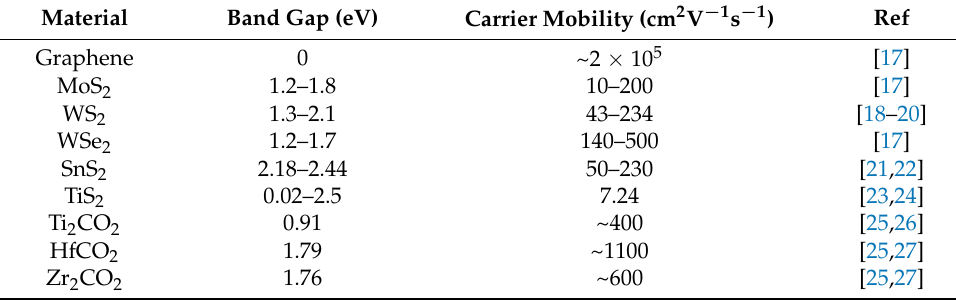
Table 1. Band gap and carrier mobility of some representative 2D